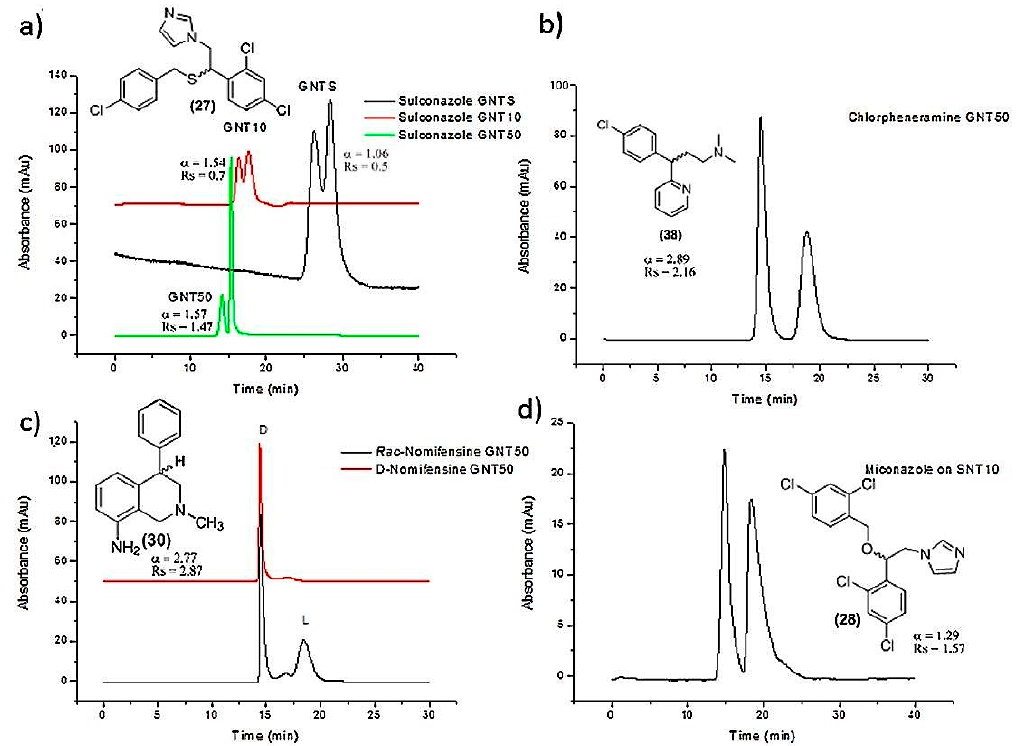
Figure 6. Effect of chiral SWCNTs on the enantioseparation of pharmaceuticals in nano-HPLC “Reproduced with permission from M. Ahmed et al. [46]. Copyright Elsevier, 2014”. Chromatograms obtained for the enantioseparation of ( a ) sulconazole on GMA-columns coated with different SWCNTs concentrations with 45:55 v / v methanol to water (0.1% TFA) at 240 nm; ( b ) chlorpheniramine on GNT50 with 40:60 w / w methanol to water (0.1% TFA) at 219 nm; ( c ) nomifensine on GNT50 with 40:60 methanol to water (0.1% TFA) at 219 nm; ( d ) miconazole on SNT10 with 25:75 methanol to water (0.1% trifluroacetic acid (TFA)) at 219 nm. The flow rate was 0.3 μ L/min, and all columns were of 150 μ m id and 20 cm length.